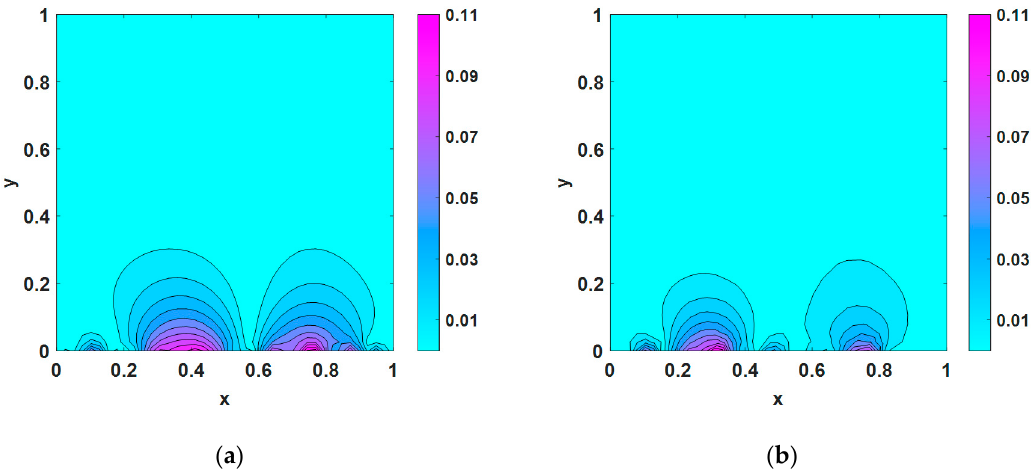
Mathematics 2020 , 8 , x FOR PEER REVIEW Figure 4. Contour plot of absolute error (%): ( a ) uniform discretization; ( b ) non-uniform discretization.